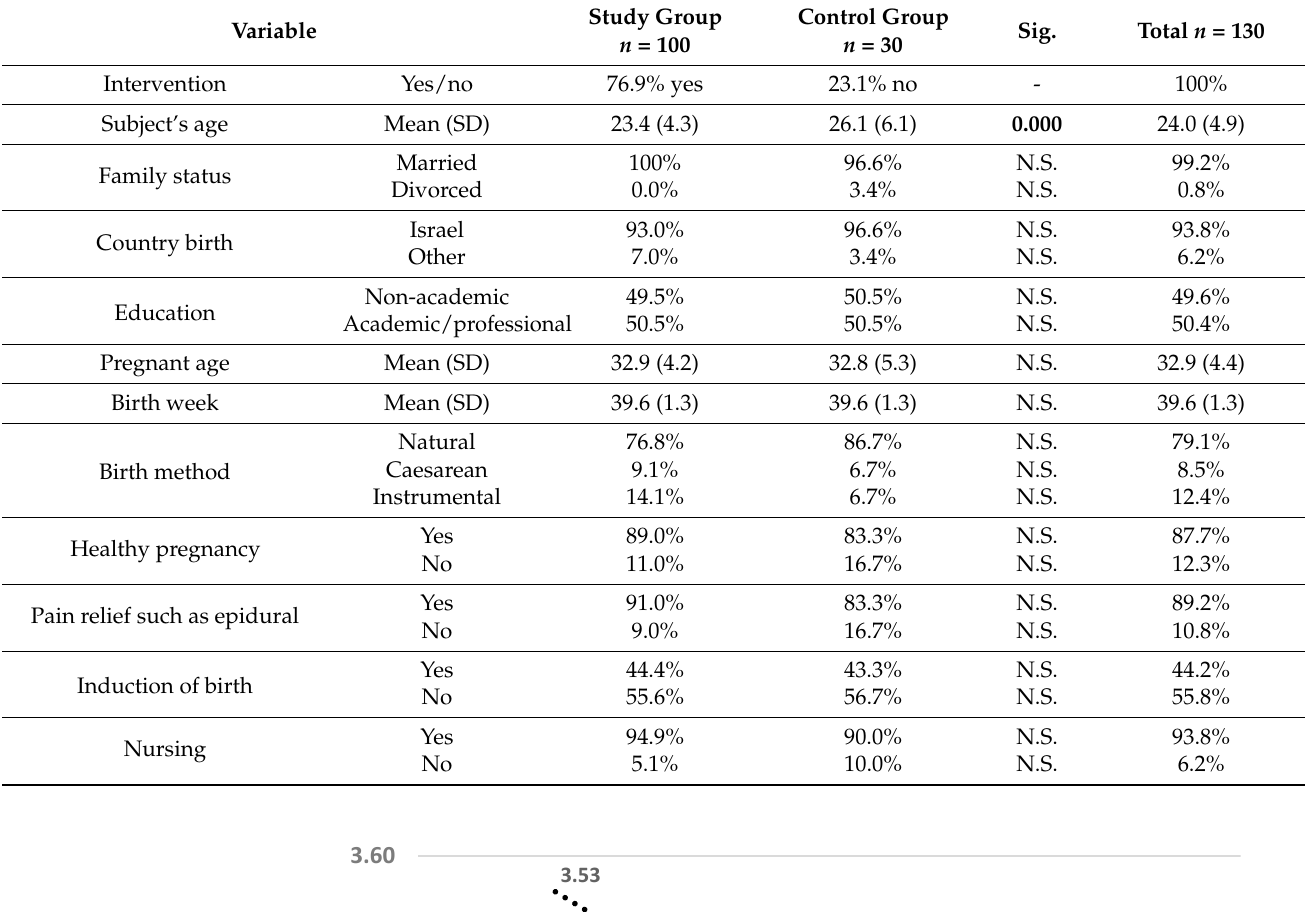
Table 1. Socio-demographic characteristics of the study and control groups (unweighted sample).